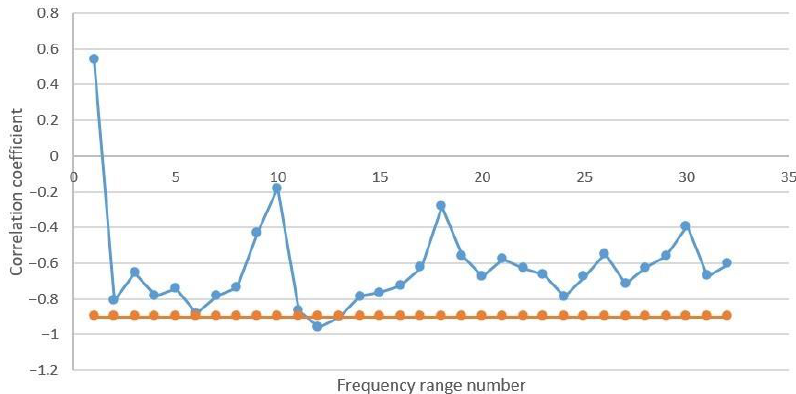
Figure 8. Distance and energy correlation estimation for the wavelet analysis on each frequency range (blue line—the correlation coefficient for different frequency ranges, red lines—0.9 limits of correlation coefficient).